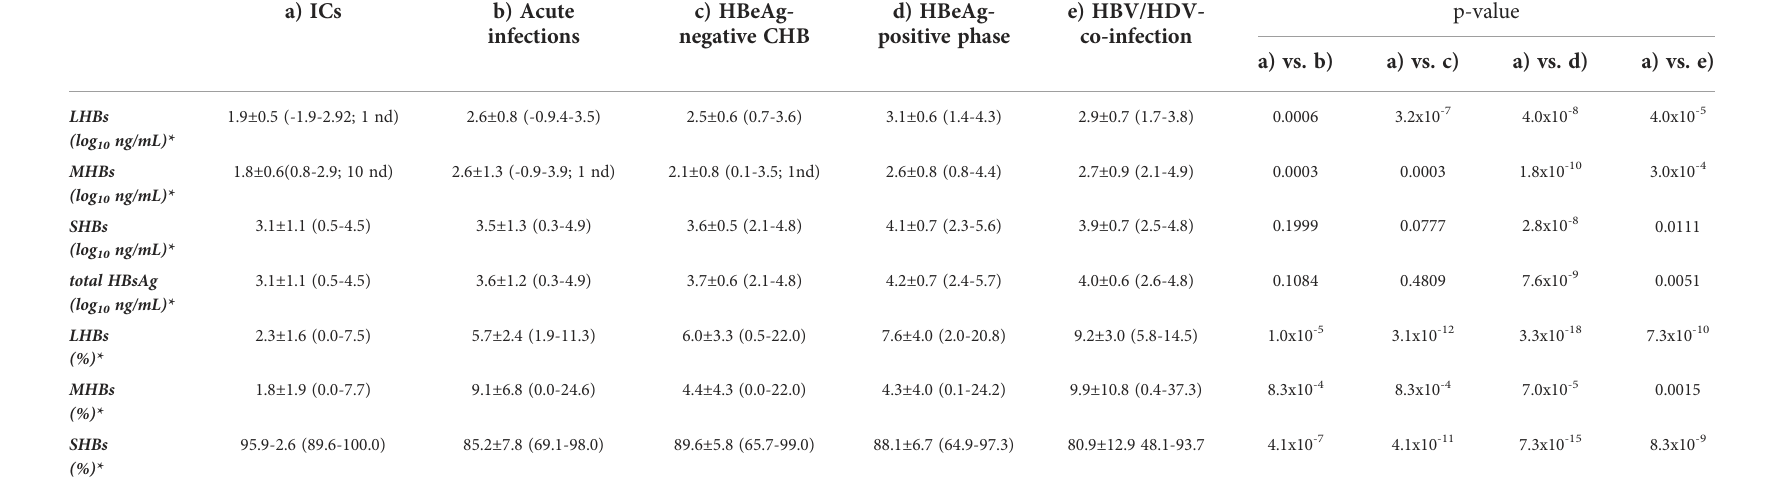
TABLE 1 Mean quantities and ratios of L, M and SHBs in different HBV patient groups and comparison of IC to other disease stages; prior published in